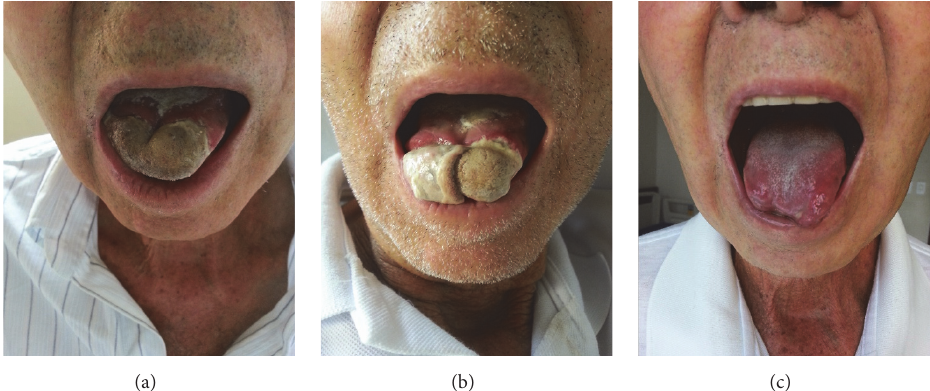
Figure 1: Clinical appearance of the tongue. (a) Tongue infarction at second day. (b) Initial auto-amputation of necrotic tongue at fifth day. (c) Tongue at 20th day presenting full epithelization.